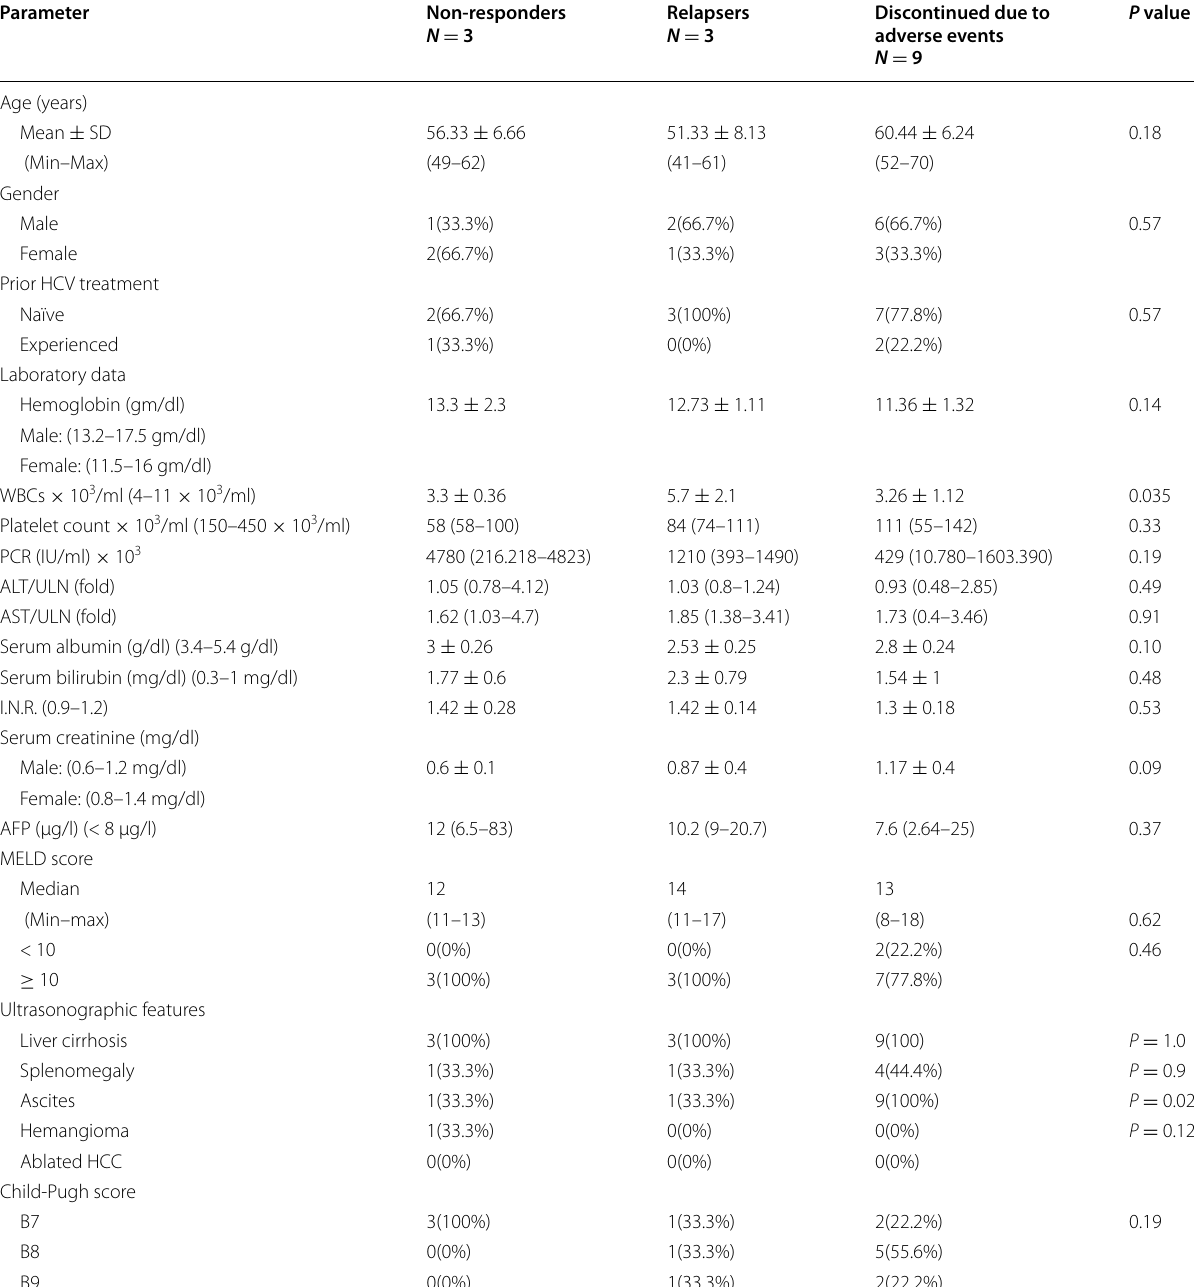
Table 2 Baseline characteristics of patients who failed to achieved